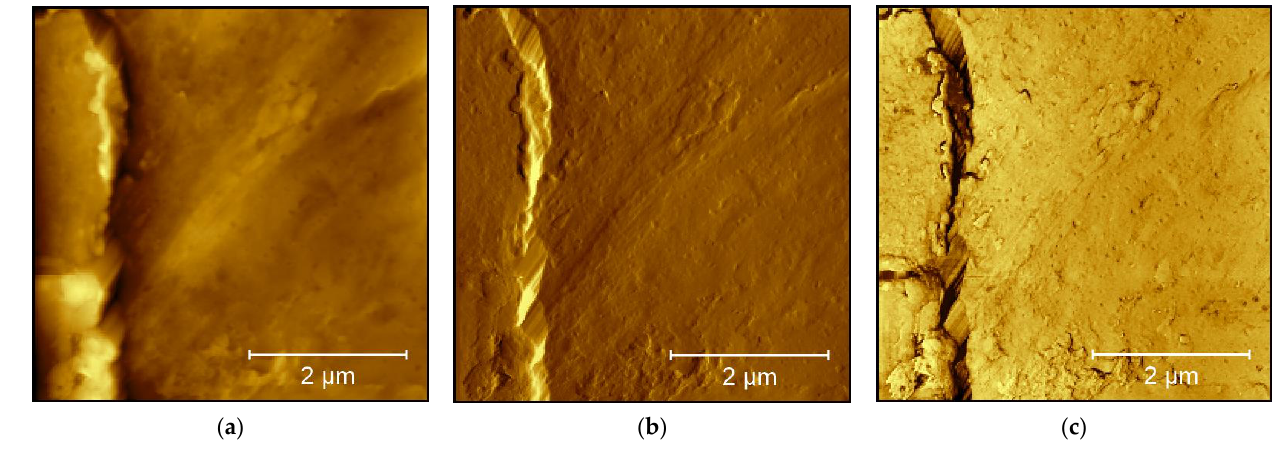
Figure 5. AFM images of a 3D printed HT–PLA surface: ( a ) topography (height range 0.7 µm); ( b ) amplitude; ( c ) phase image (phase range 12° without the crack).